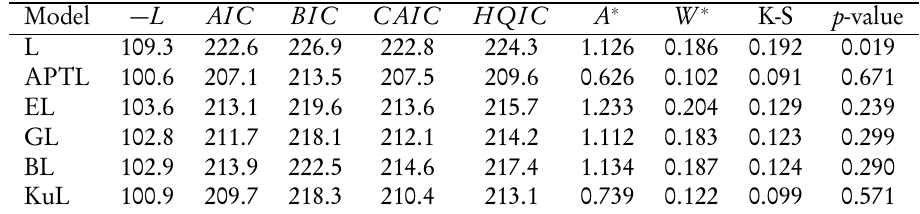
Goodness-of-fit statistics of the fitted distributions for data set 2.